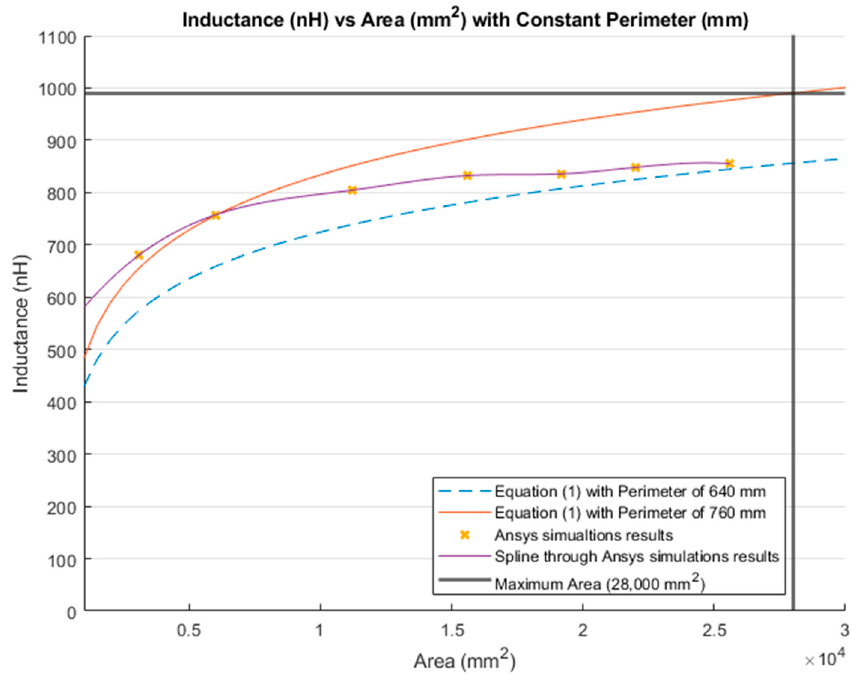
Figure 15. Comparison between theoretical inductance calculations using Equation (1) with a constant perimeter (mm) and simulations results.